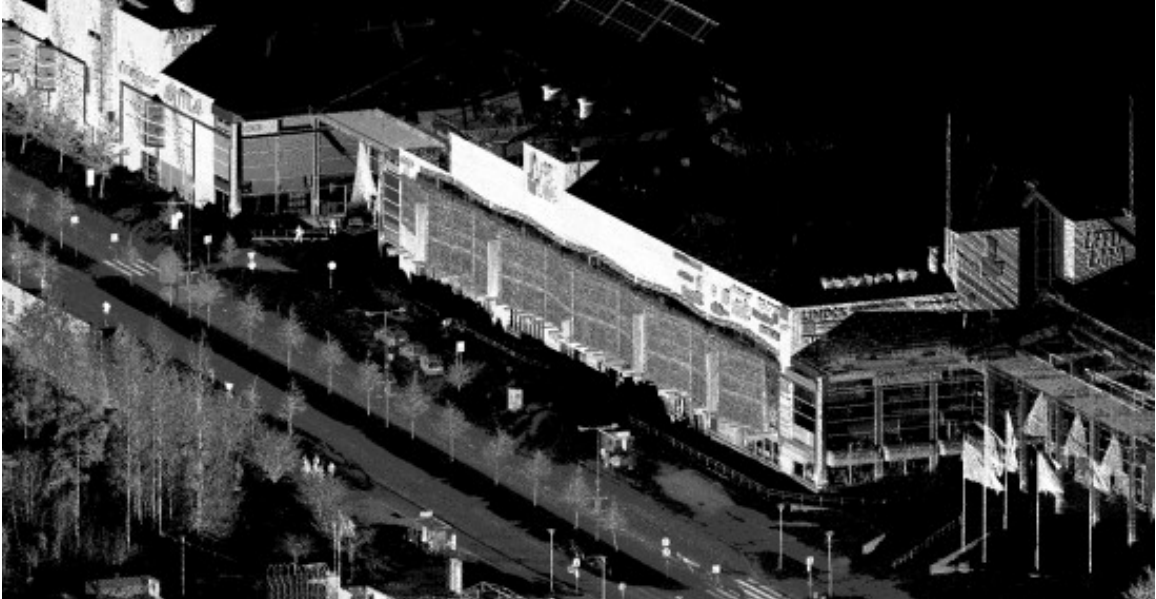
Figure 7. RIEGL VMX-250 data. There were still patches of snow on the ground during the data acquisition, and these resulted in voids in the data.